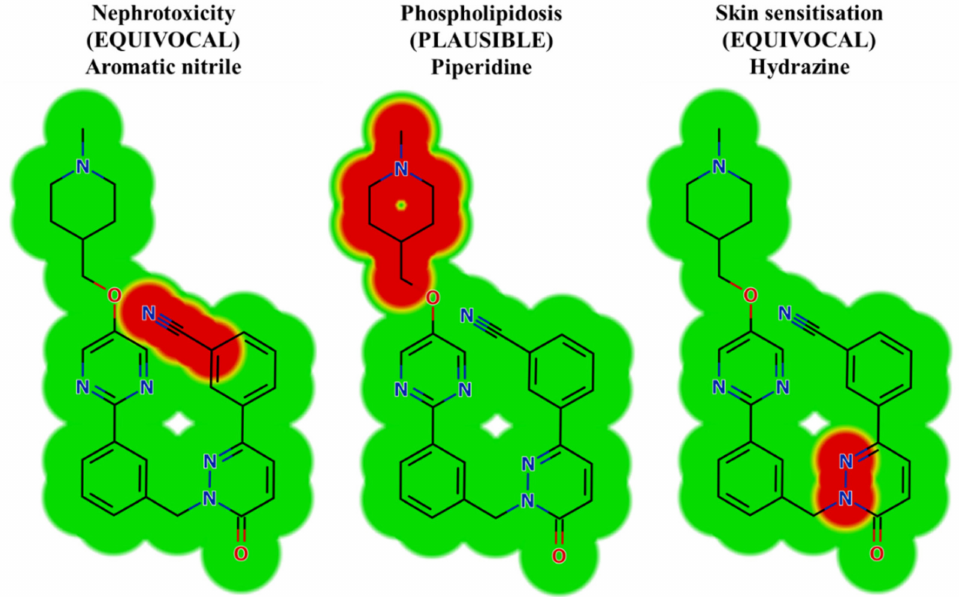
Figure 3. Results of TEP toxicity by DEREK module of StarDrop software exhibiting structural alerts with the predicted side e ff ects of TEP. Red color reveals the structural